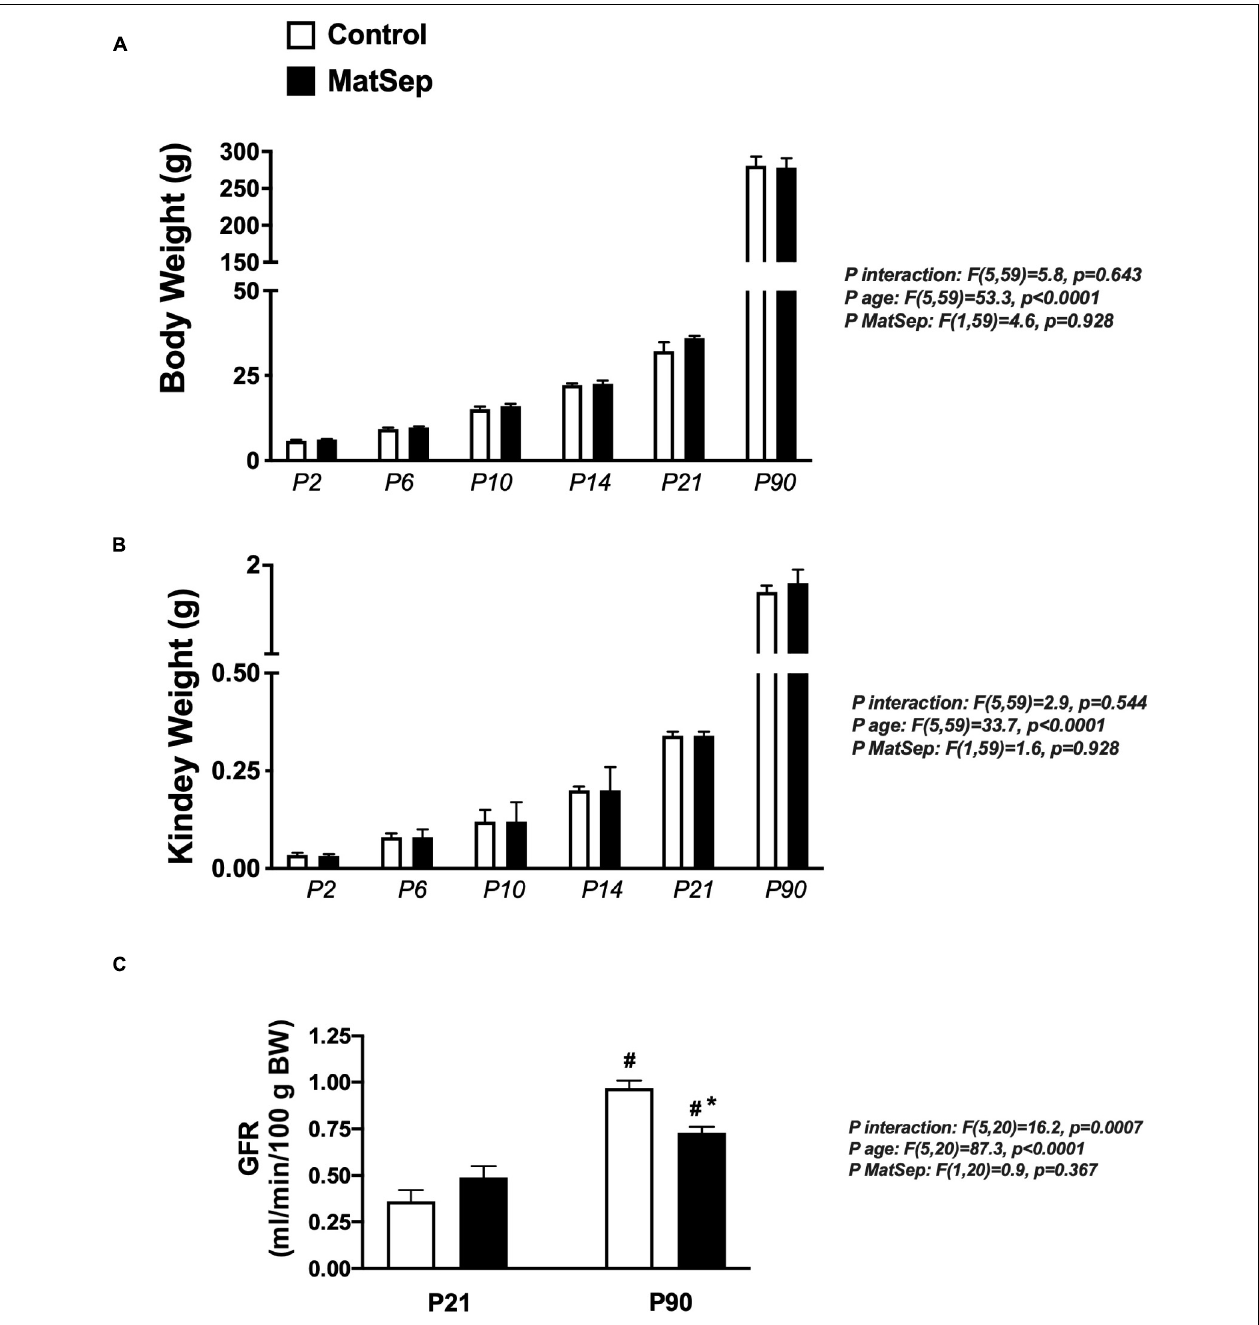
FIGURE 1 | Effect of MatSep on the trajectory from neonatal to adult male rats in: (A) body weight, (B) Kidney, and (C) conscious GFR. # p < 0.05 vs. P21, * p < 0.05 vs. C. P: postnatal day. n = 6–8 per